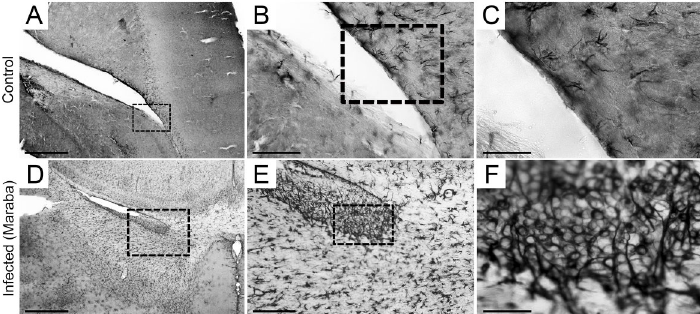
Figure 5. Low- and high-power photomicrographs of brain (lateral ventricle adjacent region) GFAP-immunolabelled sections of control ( A to C ) and infected mice at 6 days post-infection ( D to F ). The dotted areas indicate the regions of high-power images.